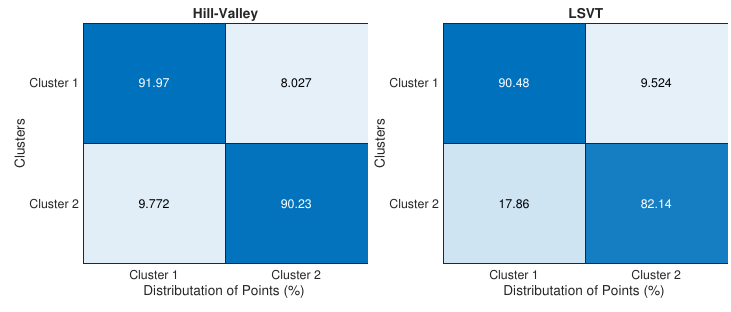
Figure 11. Cluster analysis for 2 big